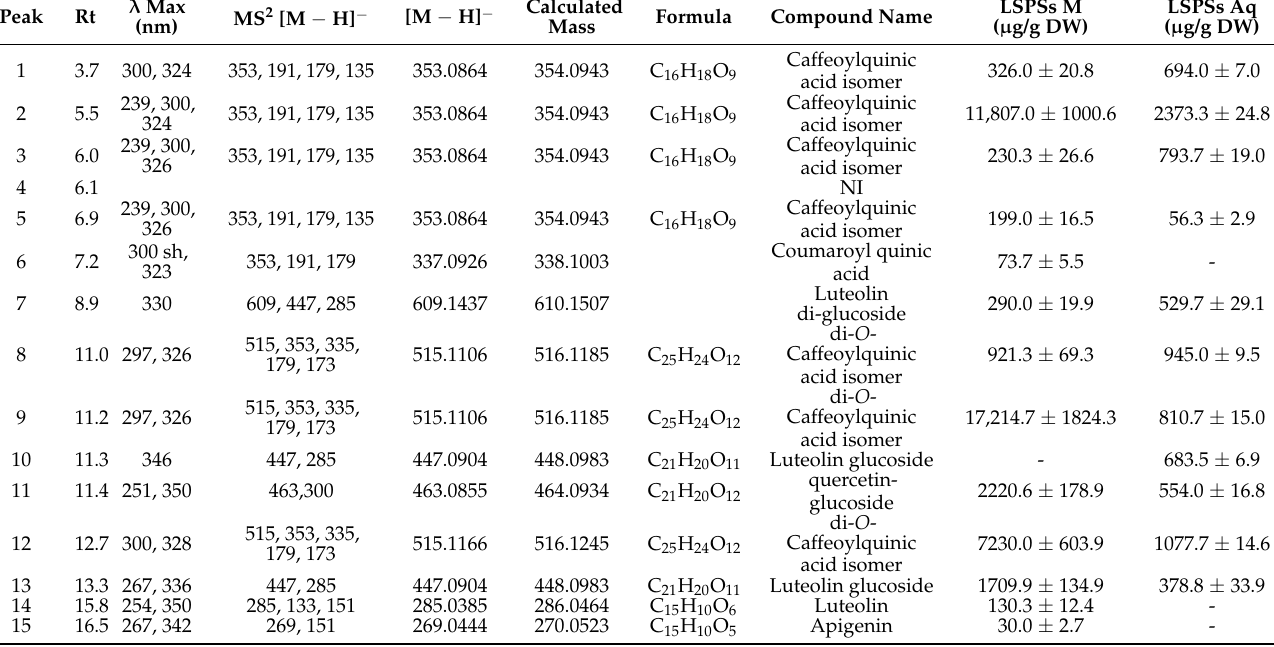
The peak numbers follow their retention time (Rt) and are the same as the ones in Figure 1. The proposed formulas and names are based on the maximum absorbance spectrum ( λ max), the m / z ratio of the parent and fragment ions detected on negative mode ([M − H] − ). NI: not identified, -: not